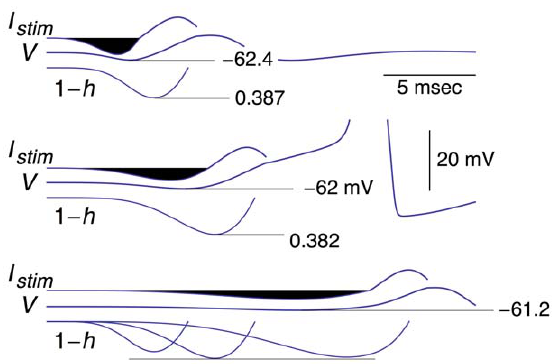
Figure 5. Same results as in Figure 4 with an expanded scale for the voltage axis of the three results and with 1 2 h shown below each simulation. All three 1 2 h results are shown superim- posed in the bottom panel. Note that the minimum level of V reached during the stimuli is, top to bottom, 2 62.4, 2 62, and 2 61.2 mV, respectively. The minimum level of h (removal of Na + channel inactivation) is, top to bottom, 0.387, 0.382, and 0.385, respectively.